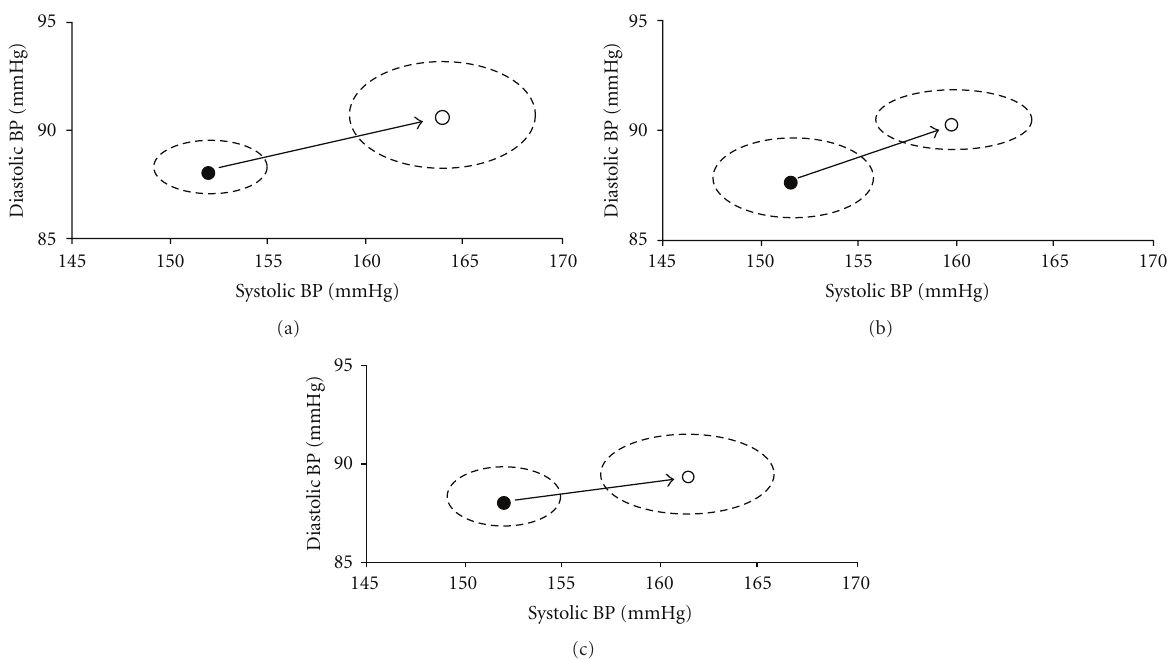
Figure 1: Vector analysis of the pair of variables “systolic blood pressure; diastolic blood pressure.” The points and the 95% confidence ellipses represent the mean values of systolic and diastolic pressure among subjects with normal ( • ) and low ( ◦ ) mini-mental state examination (a), memory with interference at 10 seconds, (b) and clock drawing test (c). The vector of impairment (arrow) is directed towards higher values of both systolic and diastolic blood